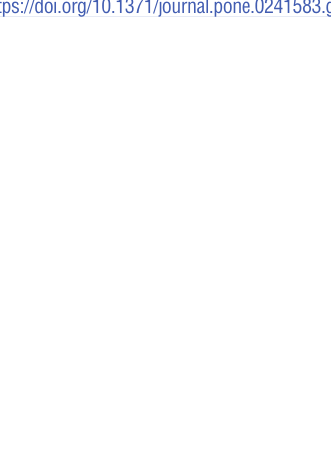
The mean standardized pour errors across participants are presented in Fig 3. An omnibus